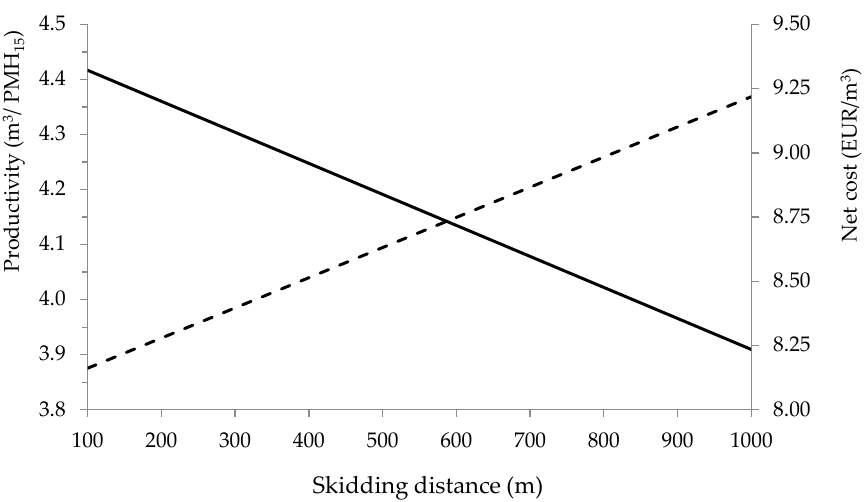
Figure 4. Productivity and costs as a function of forwarding distance (MTZ 952.2 universal tractor with FAO FAR 842 trailer).